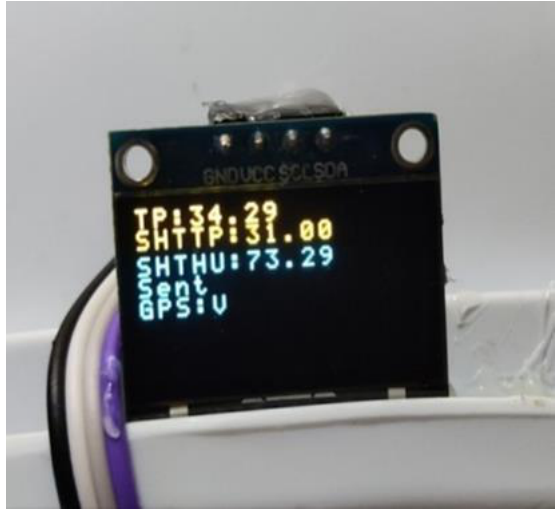
Figure 3. Display on smart